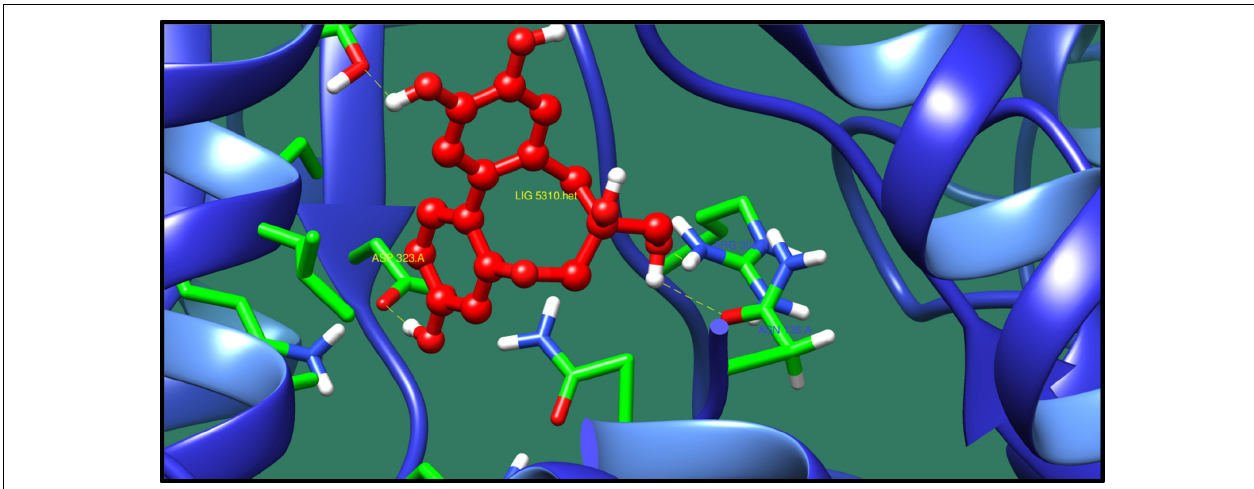
FIGURE 8 | Interaction of UDP-N-acetylmuramoyl-tripeptide–D-alanyl-D-alanine ligase with ZINC14681317 (colored in red). The interacting residues (green) are shown bonding (dotted lines) with the ligand.